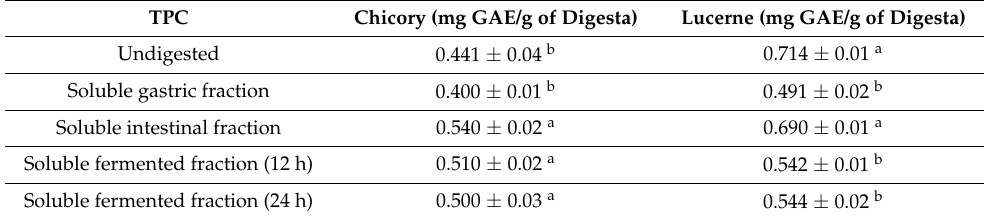
Table 1. Total phenolic content (TPC) of undigested chicory and lucerne and their digestive fractions. TPC Chicory (mg GAE/g of Digesta) Lucerne (mg GAE/g of